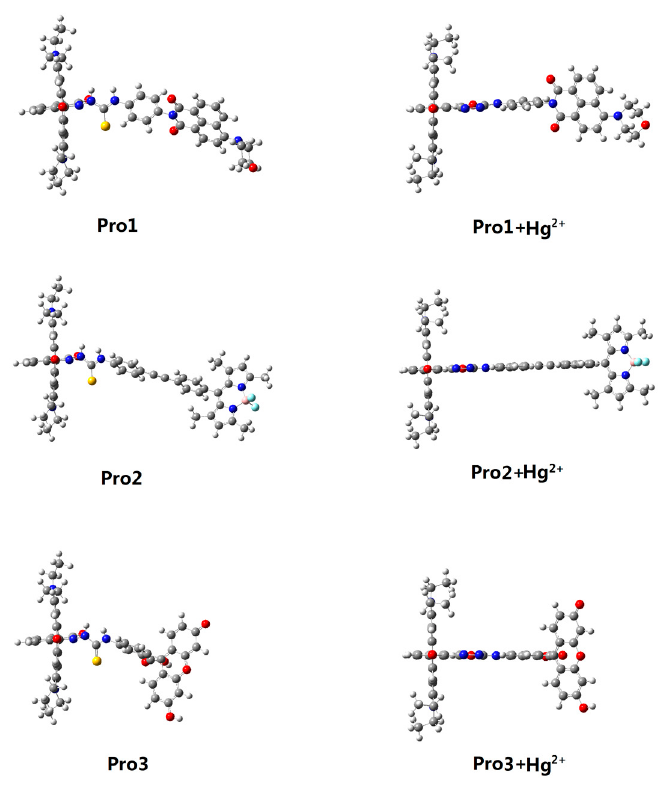
Figure 2. Optimized ground state geometries of Pro1, Pro1+Hg 2+ , Pro2, Pro2+Hg 2+ , Pro3 and Pro3+Hg 2+ in H 2 O.